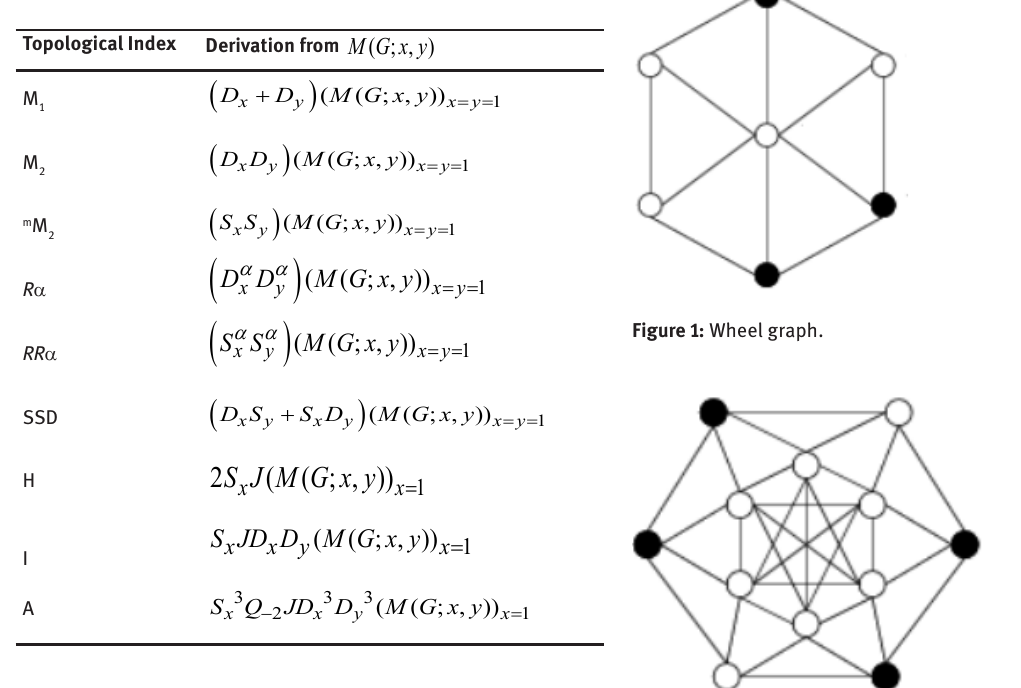
Table 1: Derivation of TIs from M-Polynomial. Topological Index Derivation from